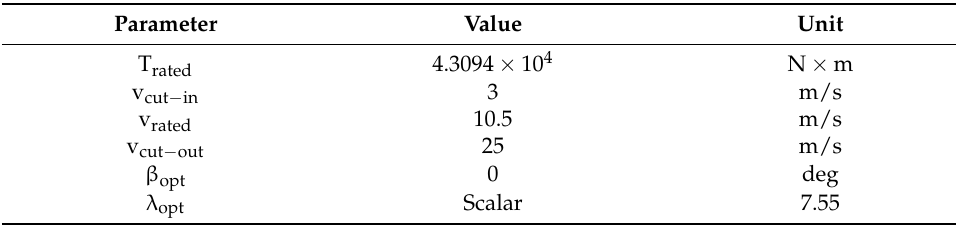
Table 1. The aerodynamic parameters of VWT.